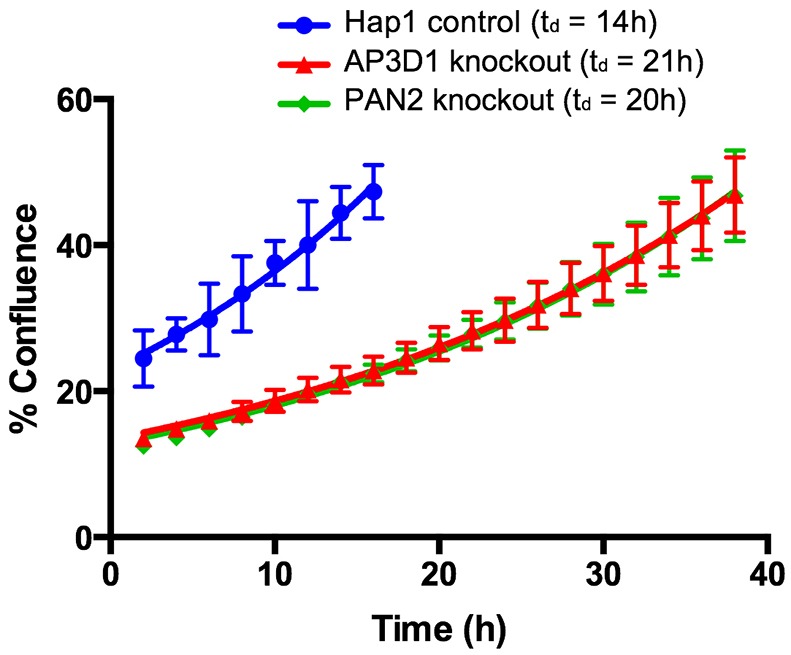
Knockout of AP-3 and PAN complexes reduces the growth rate of Hap1 cells. Plotted is the percentage confluence for the given cell lines grown in buffered pH 7.2 media for the given times, determined using an IncuCyte cell imager. Curves were fit using non-linear regression with a single exponent and doubling times (td) are shown on the graph. Doubling times for AP3D1 and PAN2 knockout cells are significantly different than Hap1 control cells (P<0.0001 by Student's t-test, n=8), but are not significantly different from each other. Error bars indicate s.e.m.